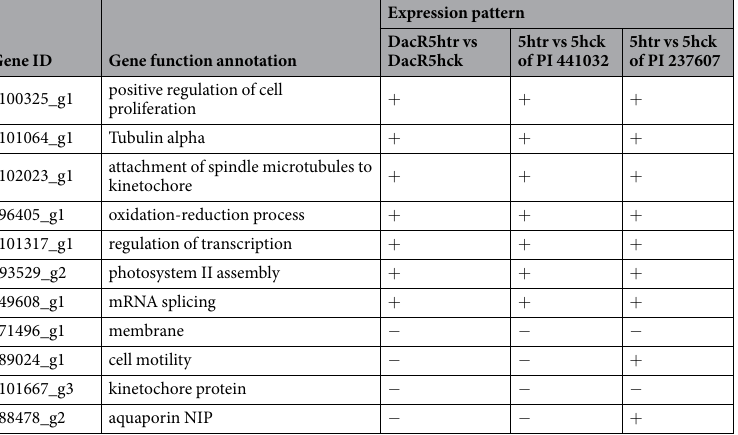
Table 4. Real-time PCR validation of transcriptome data. Total of 11 DEGs were detected by qPCR to validate their expression patterns which were revealed by data of transcriptomes. The expression patterns of DEGs were presented by transcriptomes of DacR5htr vs DacR5hck, and were validated via qPCR in samples of 5htr vs 5hck of PI 441032 and PI 237607. Symbols were used to represent the expression patterns with “ + ” meaning up- regulation and “ − ” meaning